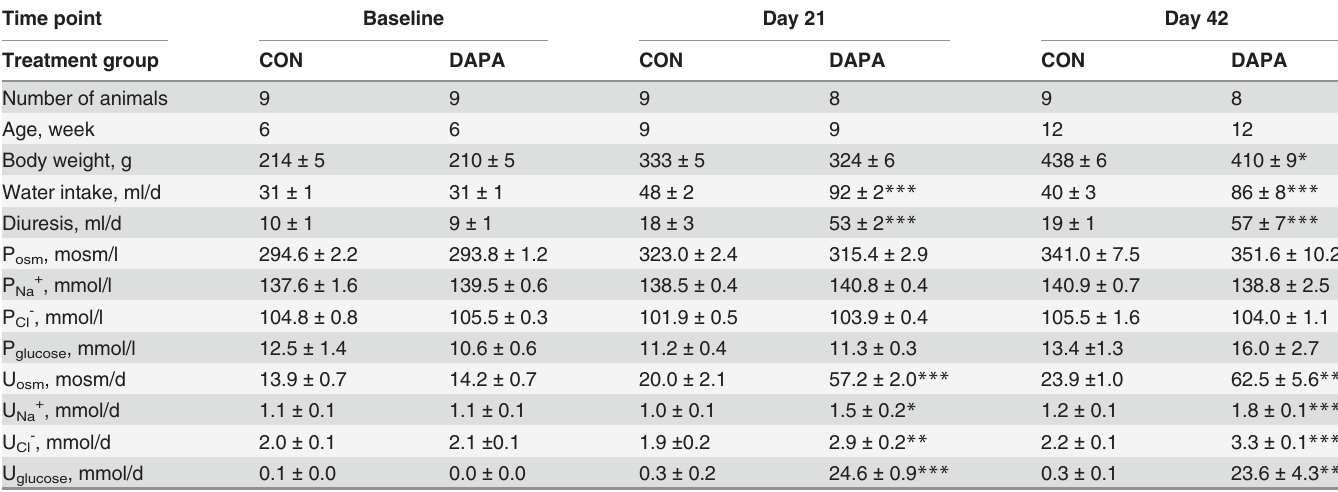
Table 1. Effect of DAPA on body weight, fluid balance and electrolytes in PCK rats.